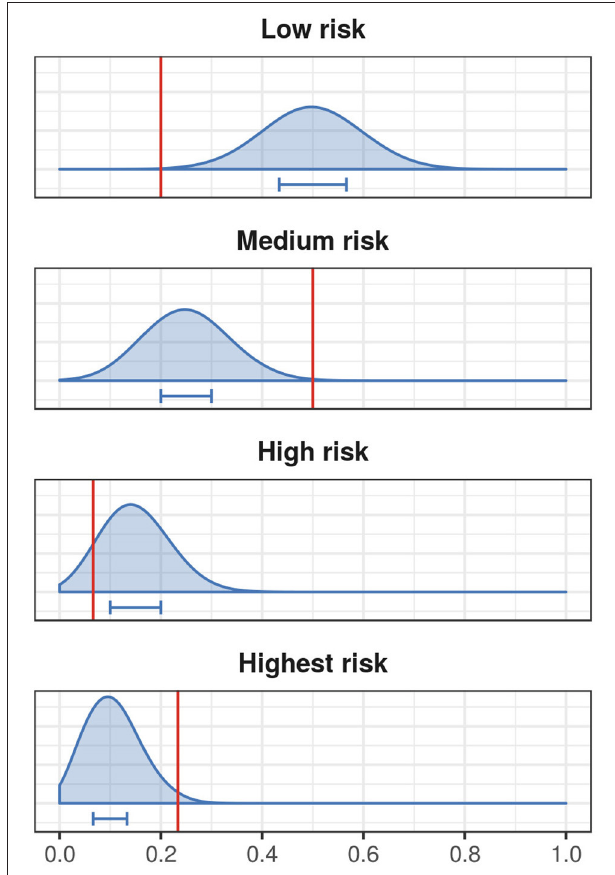
FIGURE 5 | Risk classification of empirical mallard stopover locations that are at least 10 km away from the study site. Here we show the proportion of ducks ending in low, medium, high, and highest risk hexagons as red vertical lines, and the expected distribution from the randomization described in section 2.4.1 in blue. The blue horizontal bars represent the 25–75% quantiles of the distributions.